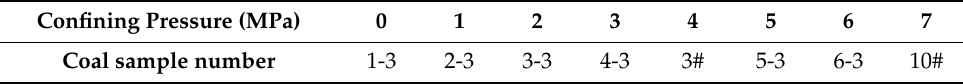
Table 1. Coal samples under different confining pressures.